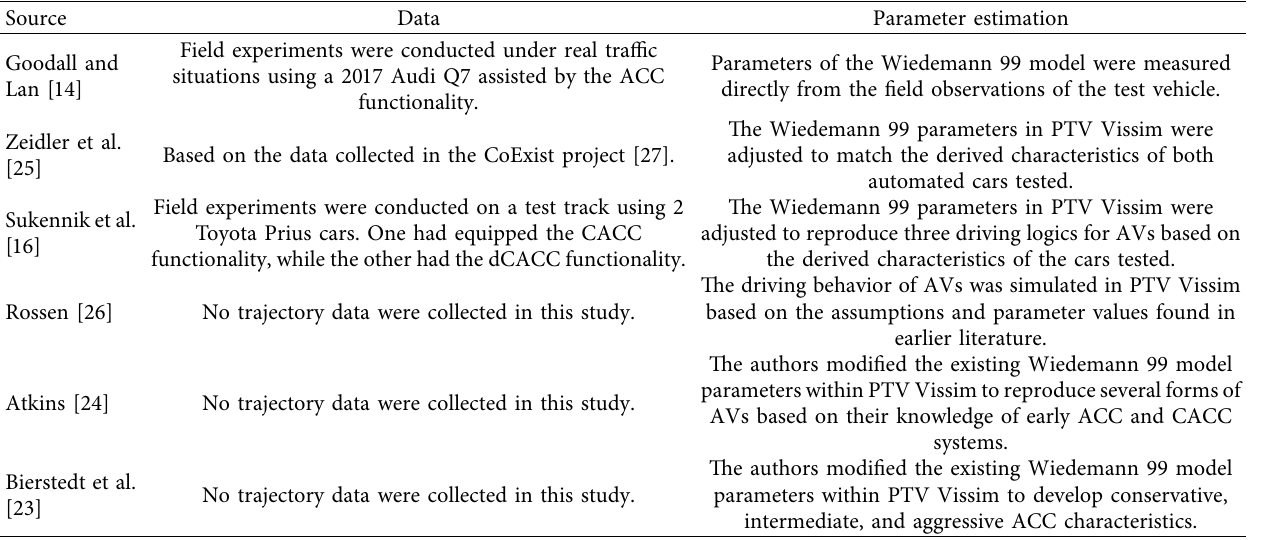
Table 6: Methods for estimating the Wiedemann 99 model parameters for AVs with Lv1 and Lv2 autonomy. Source Data Parameter